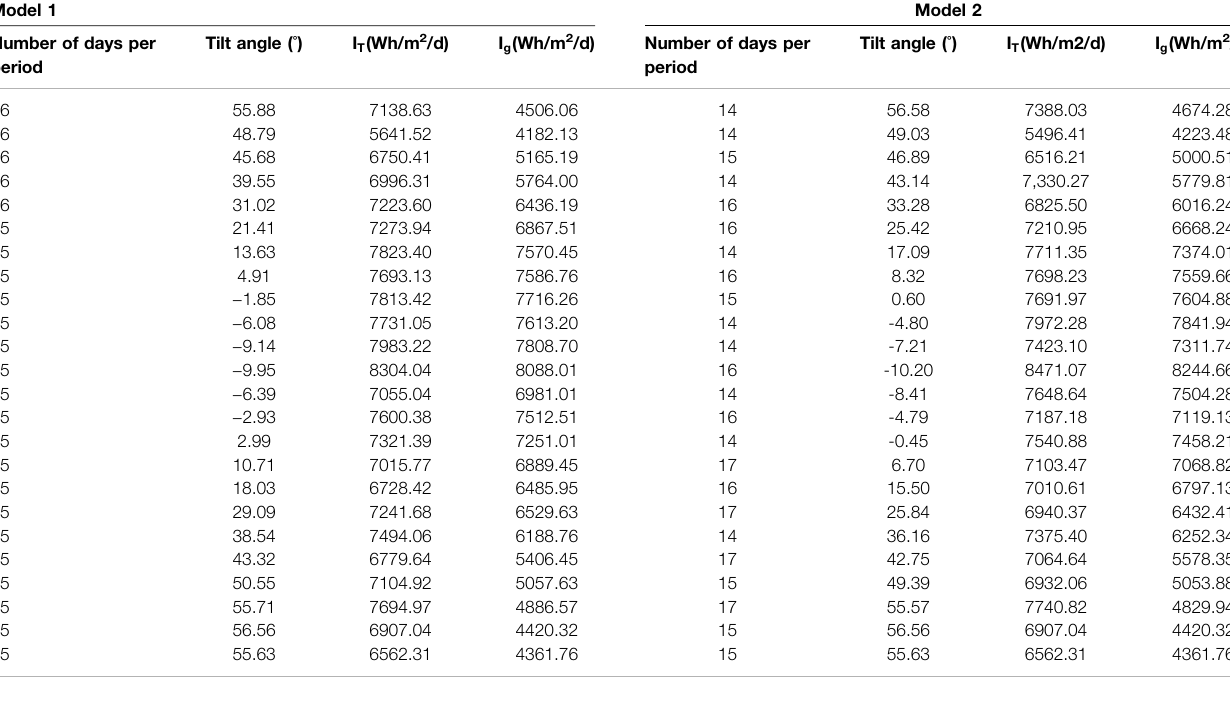
TABLE 1 | Optimal results for Yanbu when NP (cid:1) 24.